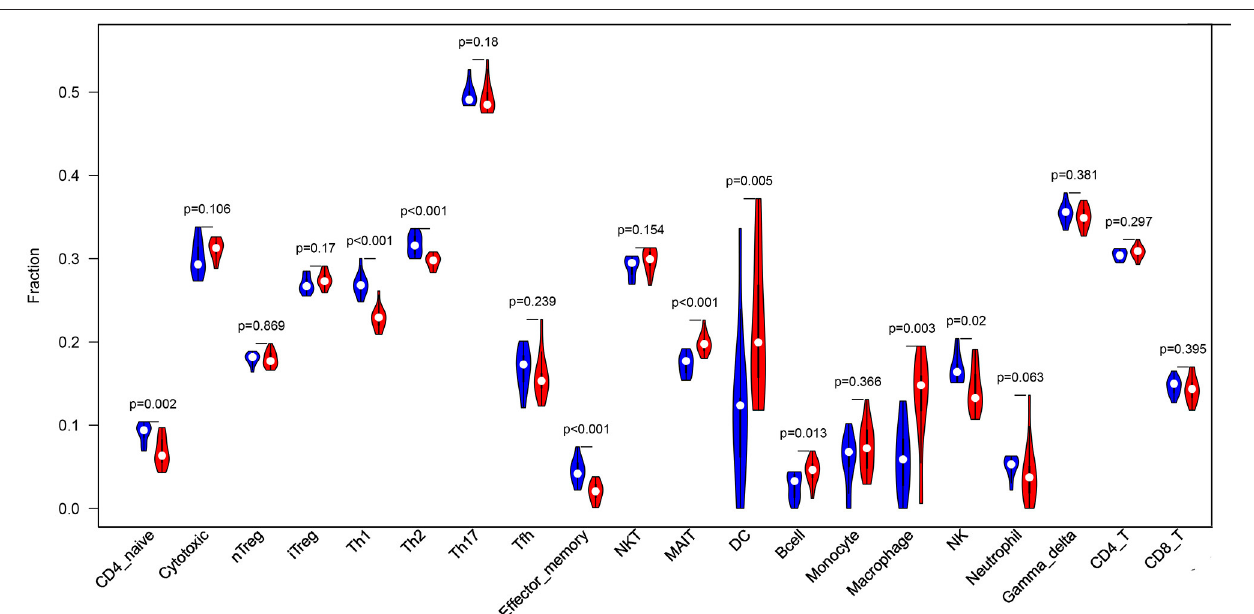
FIGURE 4 | A violin plot of the immune cell proportions in the two groups. The normal control group is marked in blue, and the AS group is marked in red. The values of p < 0.05 were considered to be statistically significant.